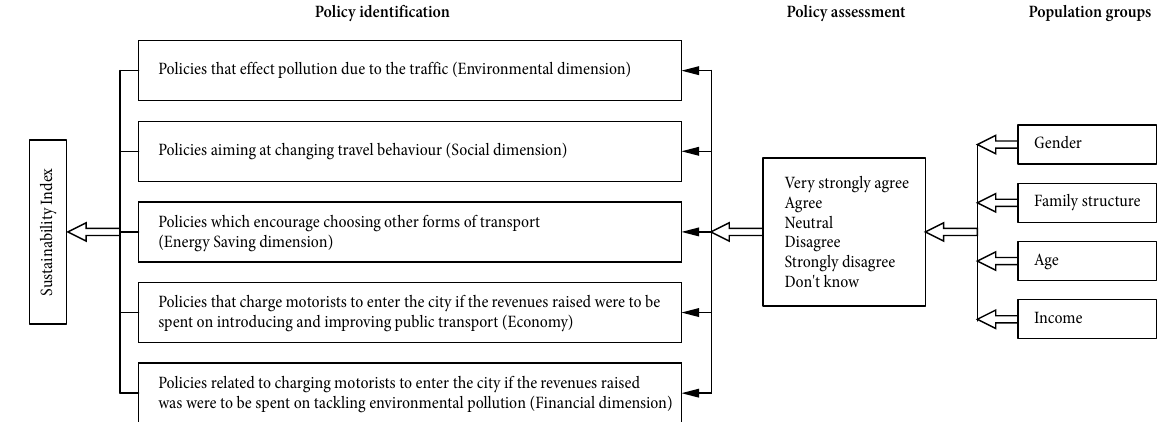
Fig. 1. The sustainable frame work AHP for Tabuk